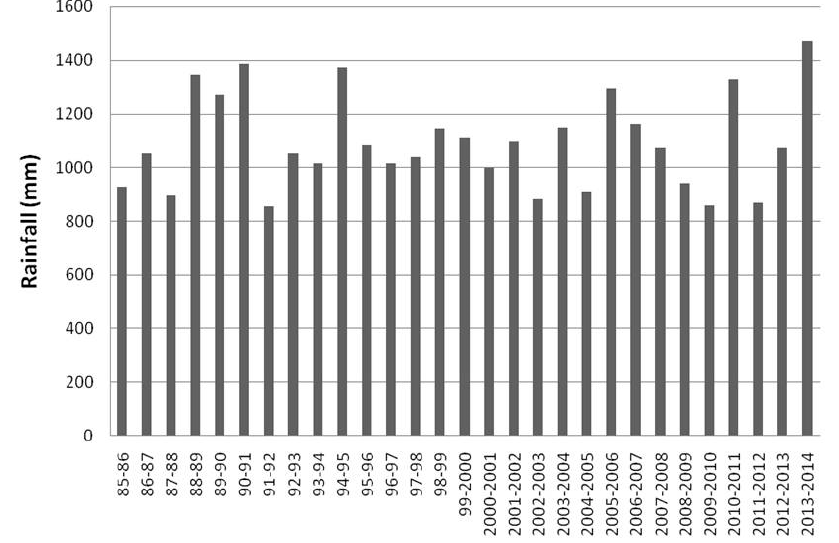
Figure 2. Annual variations in the rainfall of the Godavari Basin.